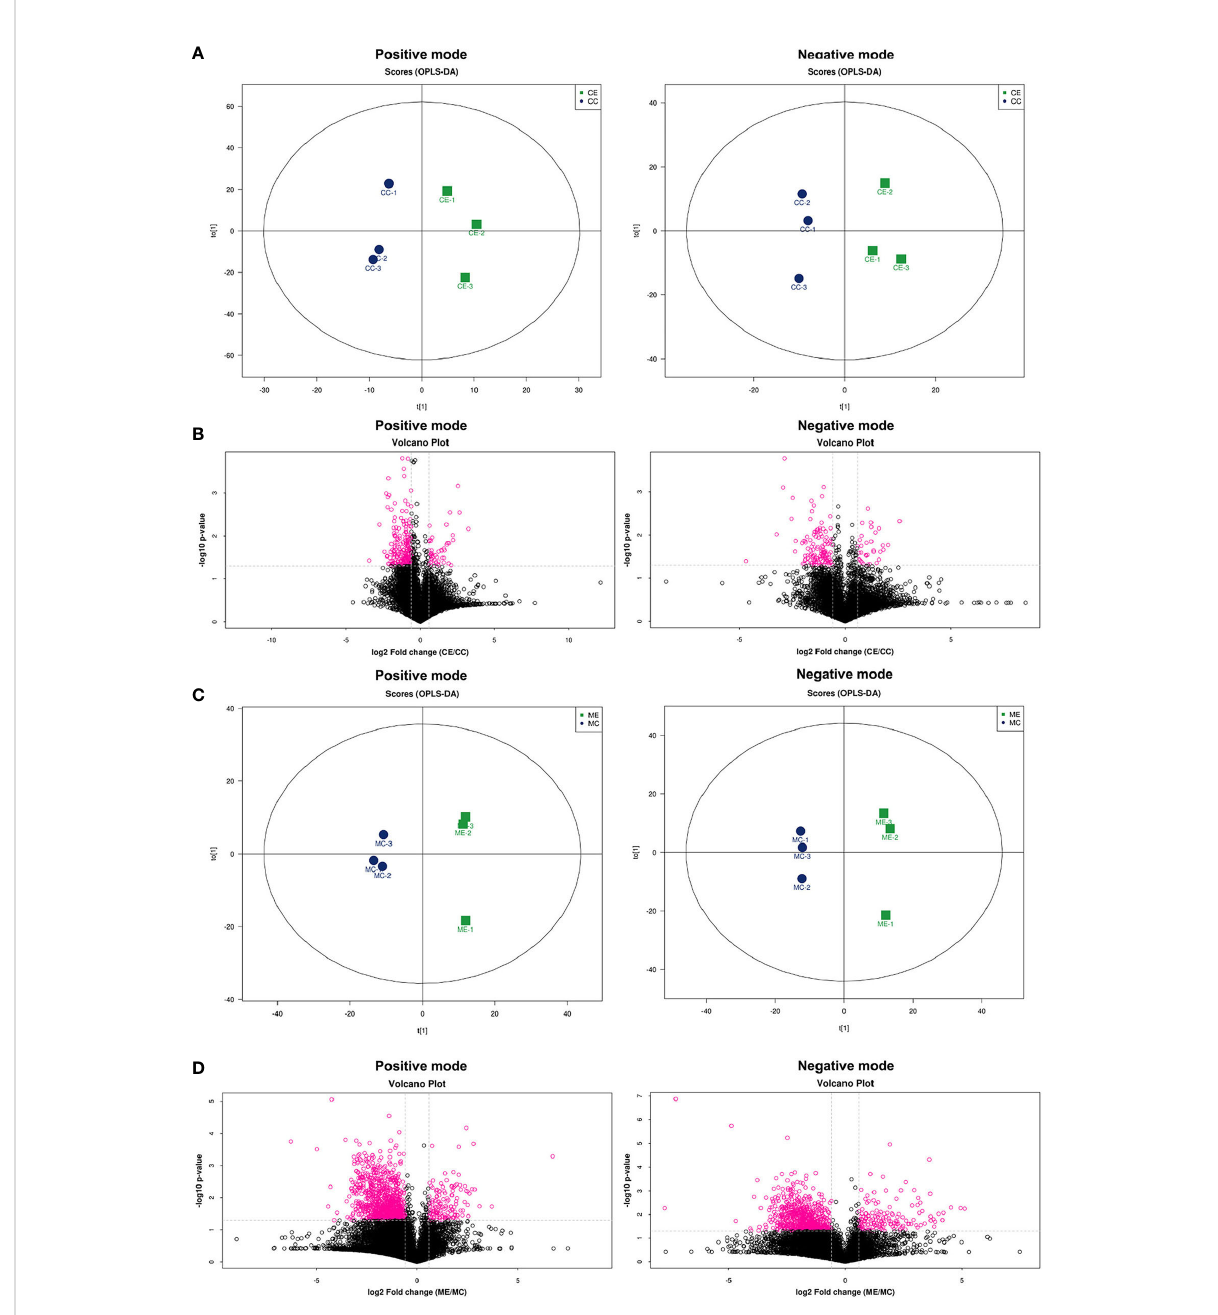
FIGURE 1 Metabolomic pro fi ling of CCs and MGCs in endometriosis and control women by PLS-DA score plots and volcano plots. Score plots of principal component analysis of metabolome in the positive ion modes and the negative ion modes from CCs (A) and MGCs (C) . These plots display a clear separation between normal and endometriosis metabolomes. The circle (blue and green) around each sample group represents the 95% con fi dence intervals. Volcano plot of CCs (B) and MGCs (D) showing the statistical signi fi cance (y-axis) and fold change (x-axis) for the difference between the metabolome of normal and endometriosis. p < 0.05, fold change ≥ 1.5 in positive ion mode and negative ion mode. CCs, cumulus cells; MGCs, mural granulosa cells; PLS-DA, partial least squares discriminant